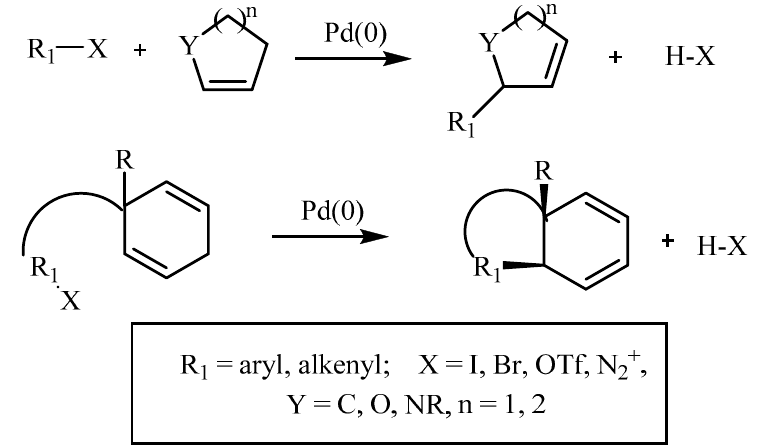
Scheme 4. Asymmetric inter ‐ and intramolecular Heck